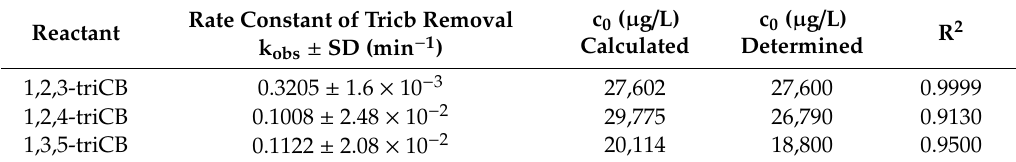
Table 3. Observed rate constants (k obs ) for removal of trichlorobenzenes (triCBs) via HDC described in Figure 5, evaluated based on a non-linear regression analysis (fitted to the first order kinetic model).